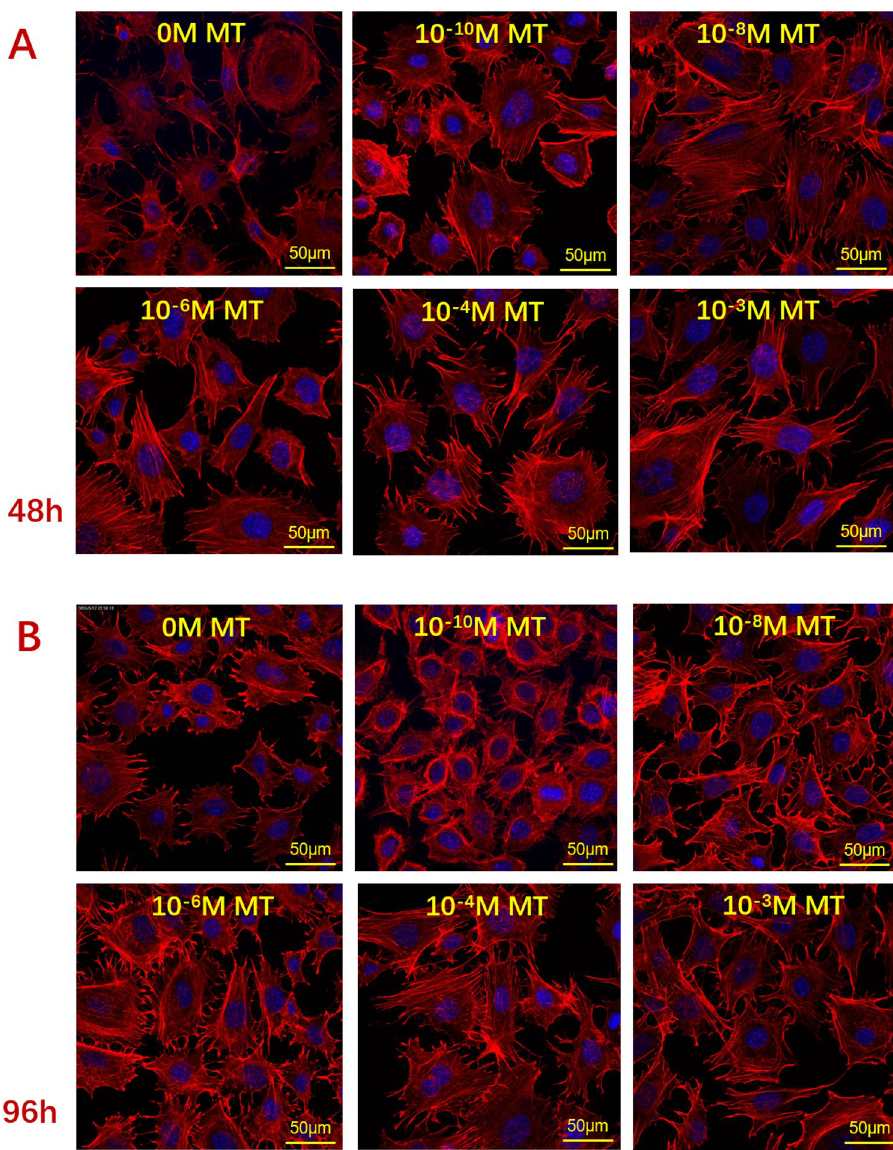
Figure 2. Effect of melatonin on ALCs’ morphology. Cells were treated with various MT concentrations (0, 10 –10 , 10 –8 , 10 –6 , 10 –4 , and10 −3 M) for 48 and 96 h, respectively. Subsequently, the cells were observed by laser scanning confocal microscope (LSCM). The magnification is 50 μm. Cells were treated with MT concentrations for 48 h ( A ) and 96 h ( B ),